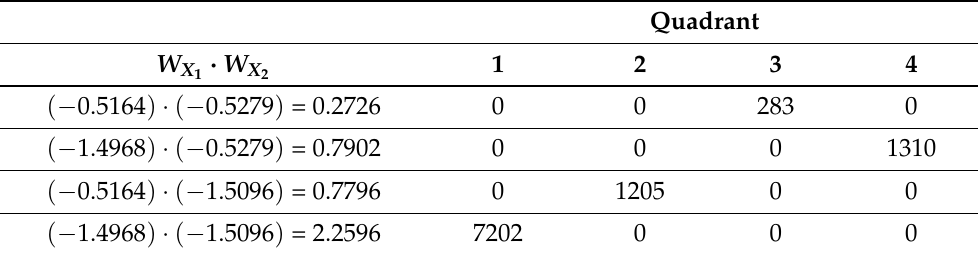
· W X 2 with respect to the four quadrants depicted in Figure 1